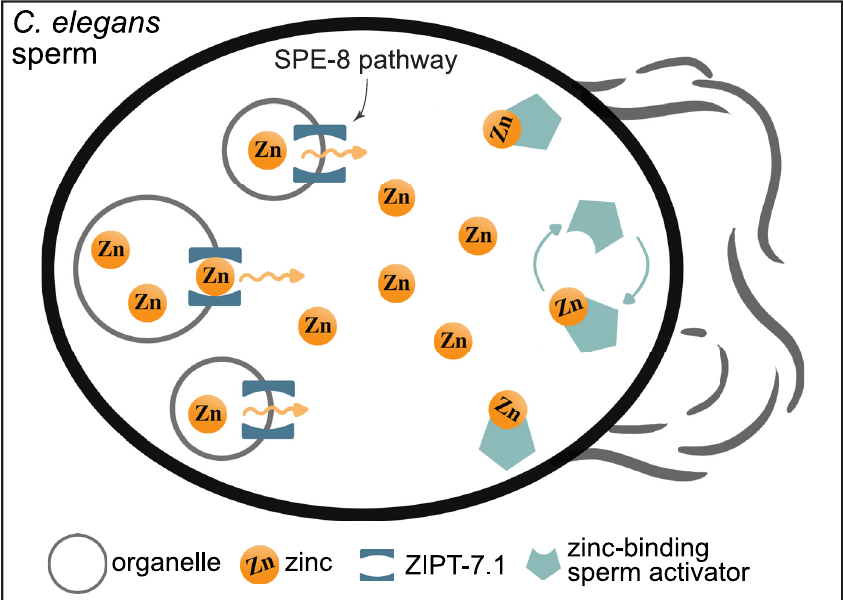
Fig 2. Model for how zinc functions as a second messenger during C . elegans sperm activation. Upon activation by the SPE-8 signaling pathway, zinc is released into the cytoplasm from intracellular storage organelles via ZIPT-7.1. High levels of cytoplasmic zinc activate yet-to-be-identified zinc-binding proteins that trigger the physiological changes to develop motility structures. SPE-8, spermatogenesis defective; ZIPT-7.1, Zrt- and Irt-like Protein Transporter